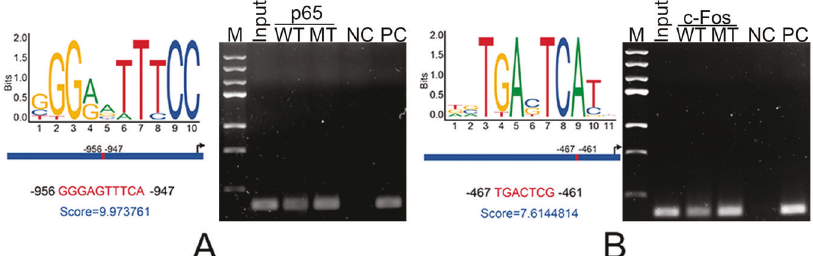
Fig. 6 The Hoxd13 mutation regulated the transcription of Rank via p65 and c-Fos. A The probable binding site of p65 in the promoter of Rank was predicted by JASPAR, and was con fi rmed by ChIP assay. B The probable binding site of c-Fos in the promoter of Rank was predicted by JASPAR, and was con fi rmed by ChIP assay. All experiments were repeated three